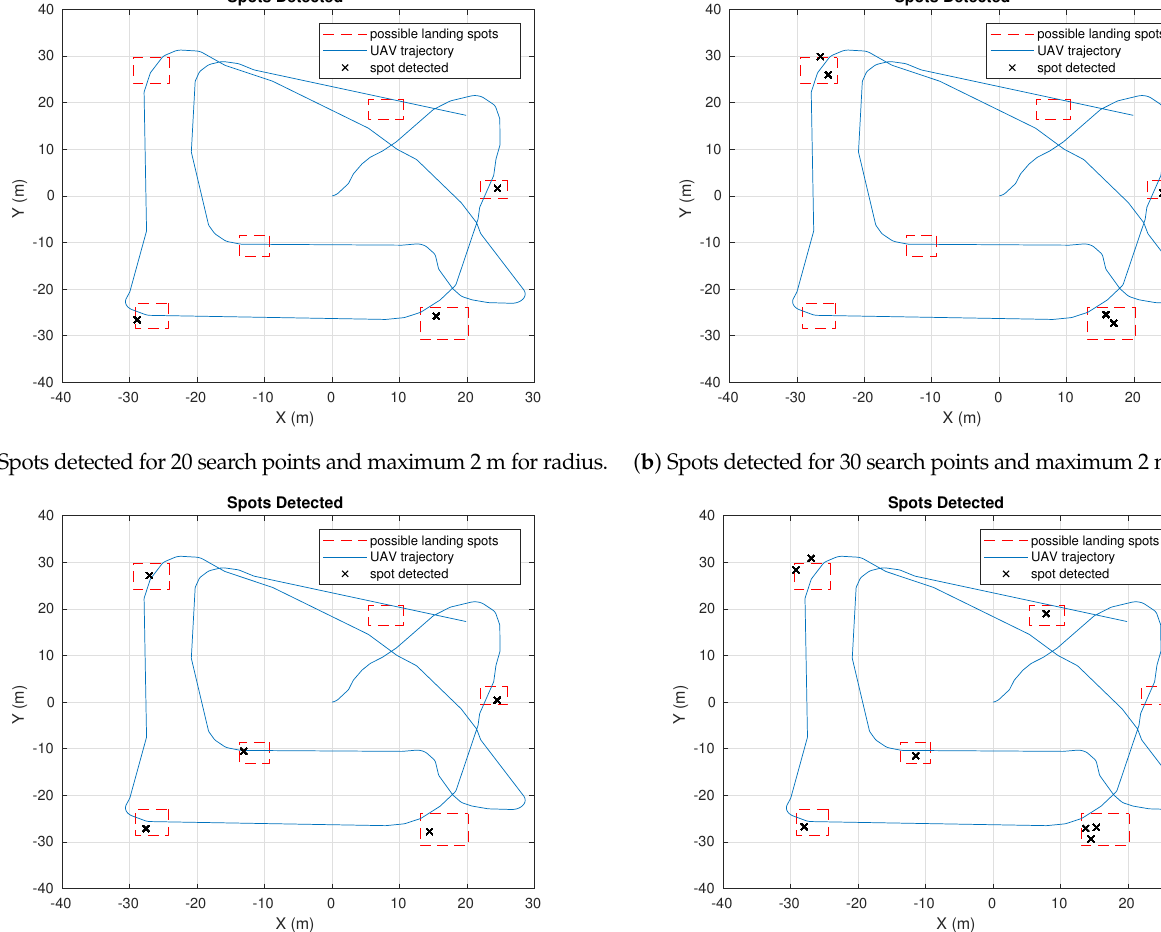
Figure 10. Spots detected for the second scenario with different parameters.